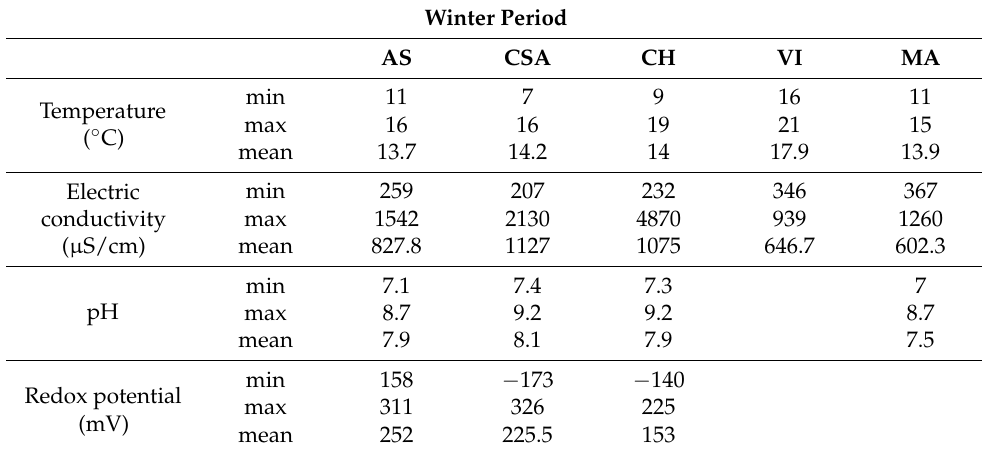
Table 3. Wintery physico-chemical parameters.